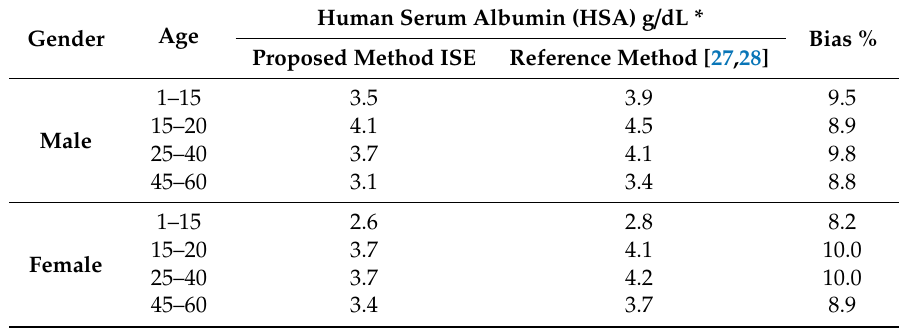
Table 3. Application of the proposed sensor to the determination of albumin in the human blood serum.